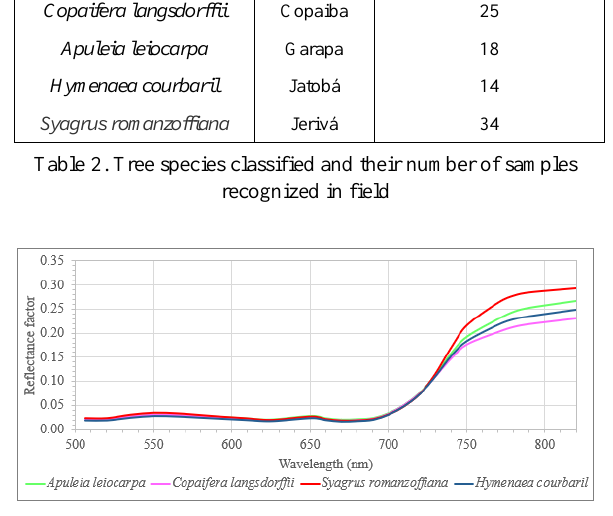
Figure 4. Sample spectra of each tree used to the classification Tree species were associated to the superpixels using their position acquired in field. In sequence, 80% of the samples were randomly separated to train the classifier while, 20% were separated to validate the results. Regarding the features used, they were 28, where 25 corresponds to the spectral bands acquired and three to the three first principal components (PC) of the mosaic of hyperspectral images. The PC were extracted using the ENVI software and the number of PC were chosen because they represented more than 95% of data